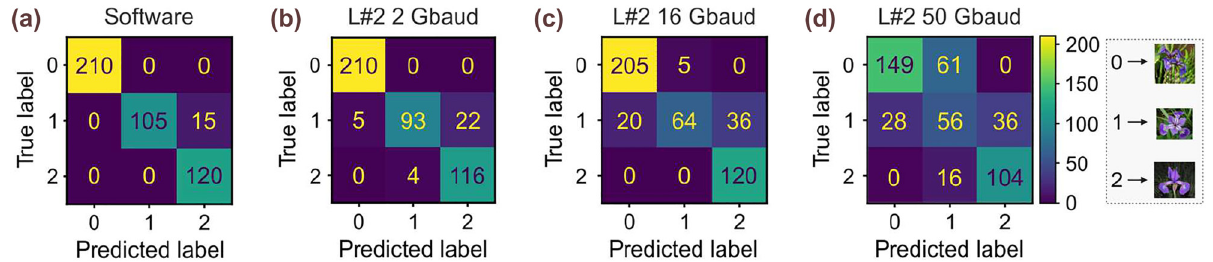
Figure 7: Experimental results: (a)–(d) Confusion matrices derived from the NN inference (a) via software, (b)–(d) when the linear part of the first layer is calculated via the SiPho chip at 50 Gbaud/axon and the second layer at (e) 2, (f) 16, and (g) 50 Gbaud/axon. = 0.12 A ∕ W with a bandwidth of B = 50 GHz, an ER = of n √ pd = 8 and i = 1 , 5 E − 11A ∕ 10 dB and ADC Hz Ebits ref